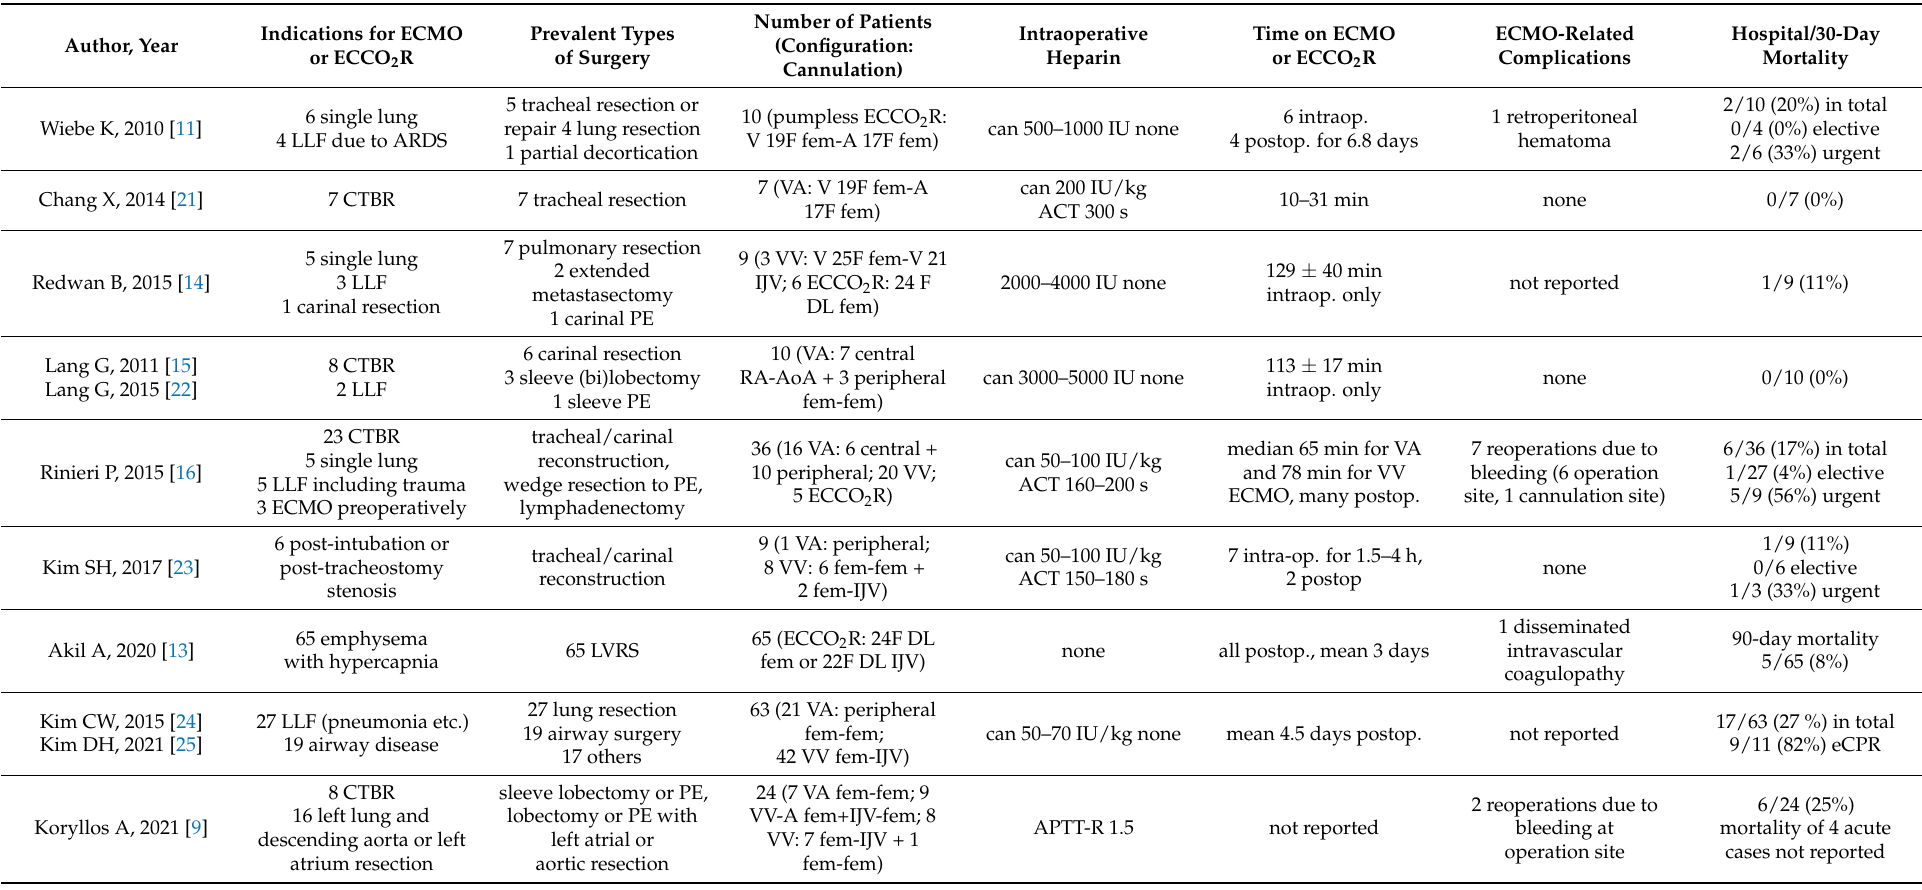
Table 1. Case series describing at least 5 patients undergoing thoracic or airway reconstruction procedure on ECMO or ECCO 2